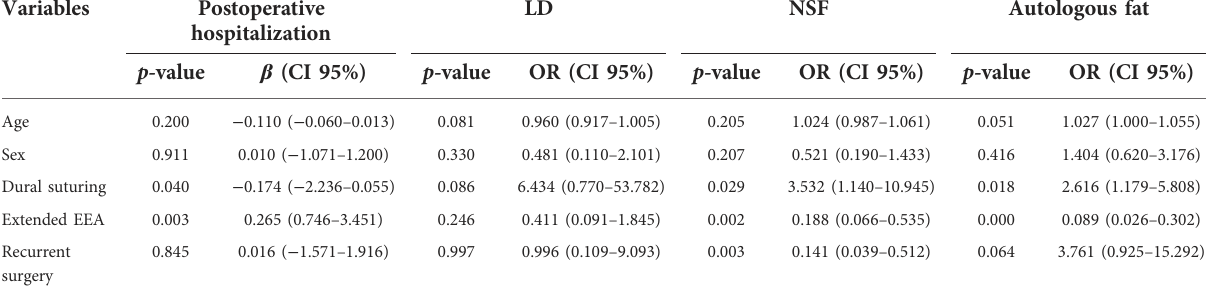
TABLE 3 Regression analysis in risk factors of the observed signi fi cances. Variables